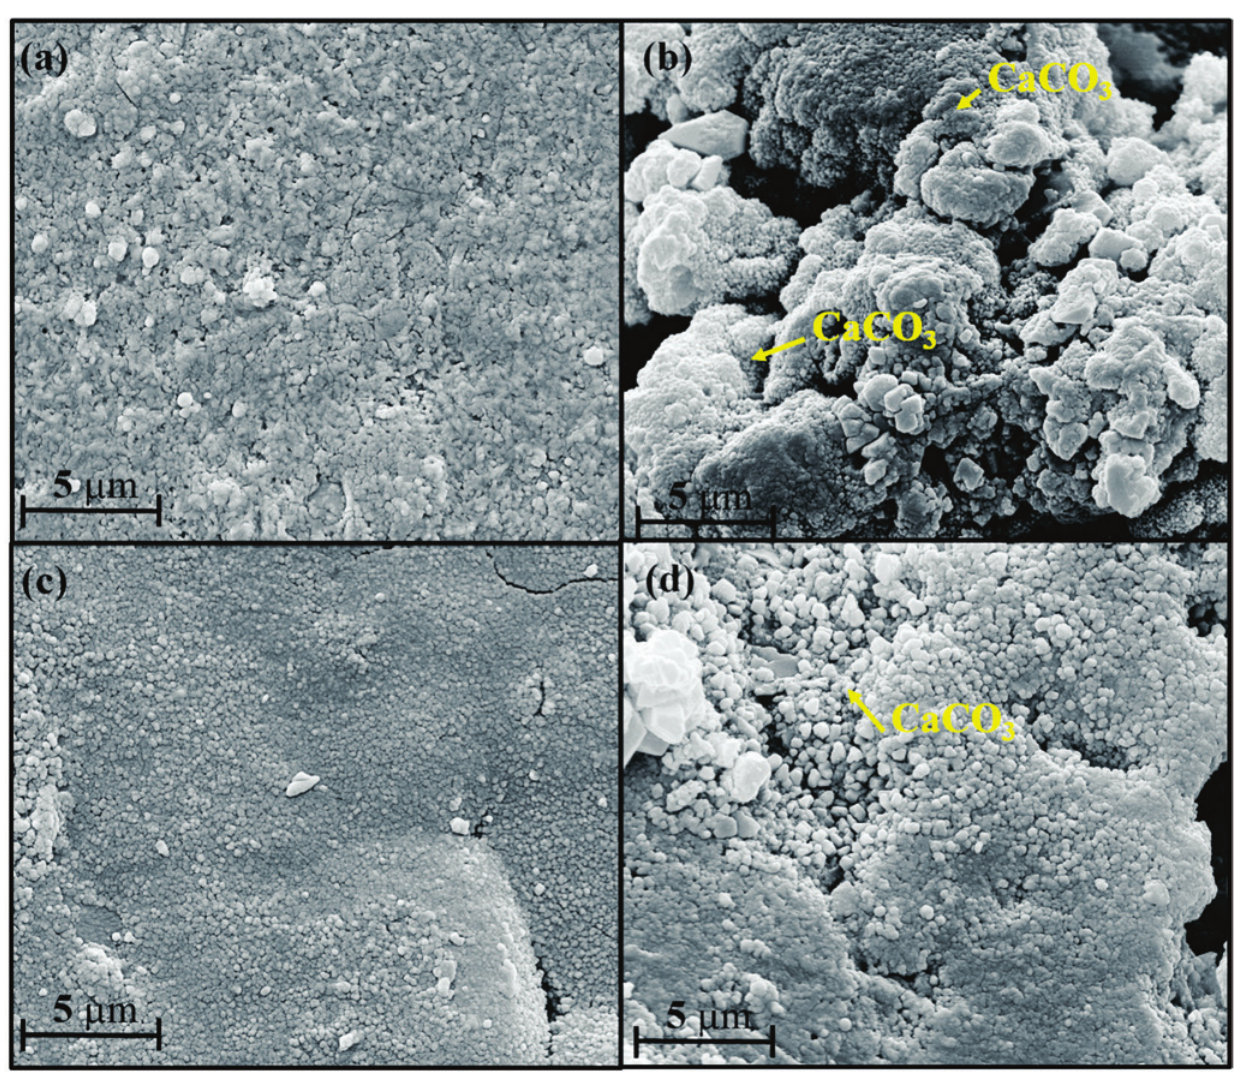
Figure 2 SEM of mortars after 28 days of curing at magnification of 12.000x. (a) REF_WT. (b) SP_IM. (c) REF_PB and (d)